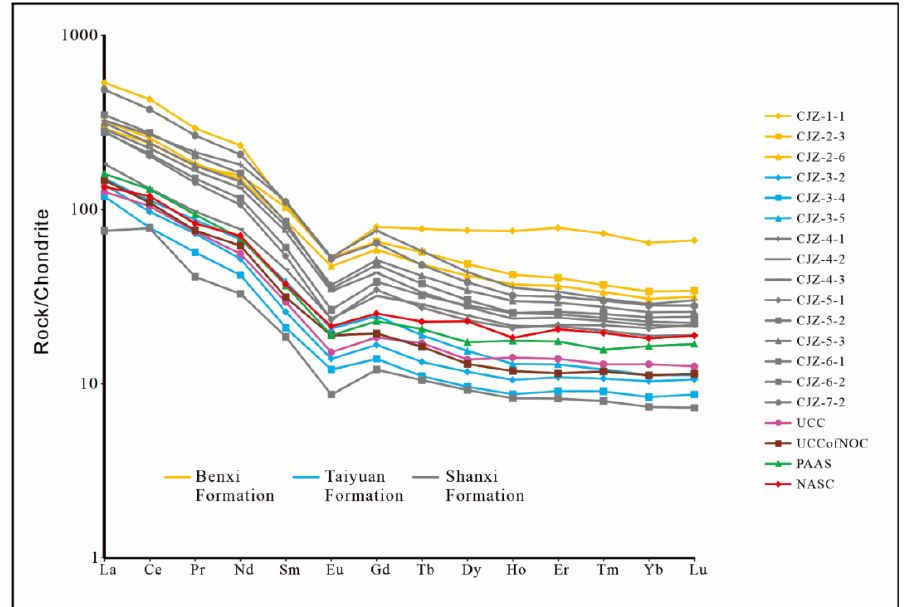
Figure 4. Rare earth element distribution for the Benxi − Shanxi formations at the Liulin section.